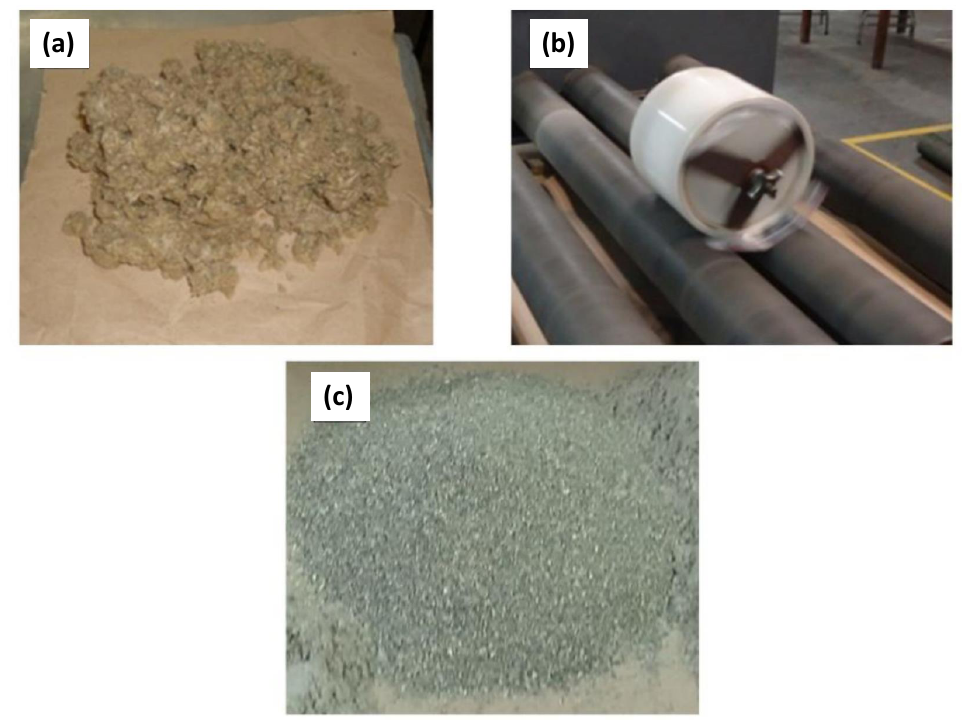
Figure 1. Pictures of the SW. ( a ) SW fiber, ( b ) Ball milling process and ( c ) SW after the milling process. θ between 5 and 80° and a sweep of 0.0263°. For the SEM-EDS, a JEOL-JSM-6490-LV device was used, loading the sample on a graphite ribbon before applying a thin gold (Au) coating in a DENTON-VACUUM Desk IV